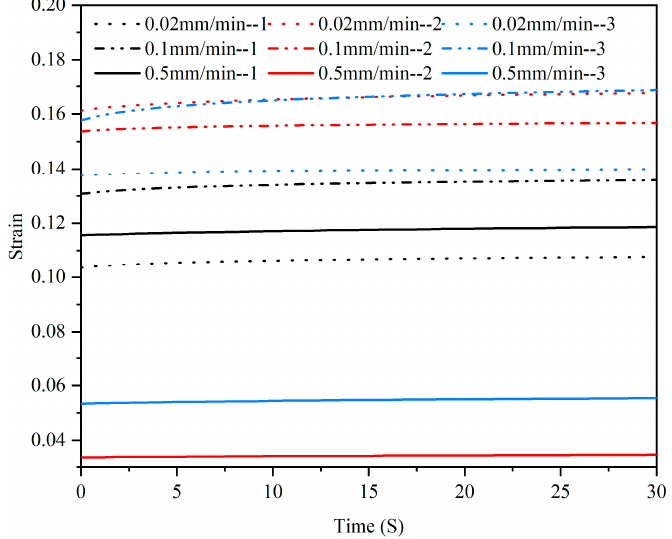
Figure 9. Creep strain–time curves of three samples at different rates in the first 30 s.